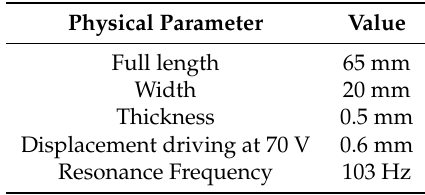
Table 1. Specification of FDK